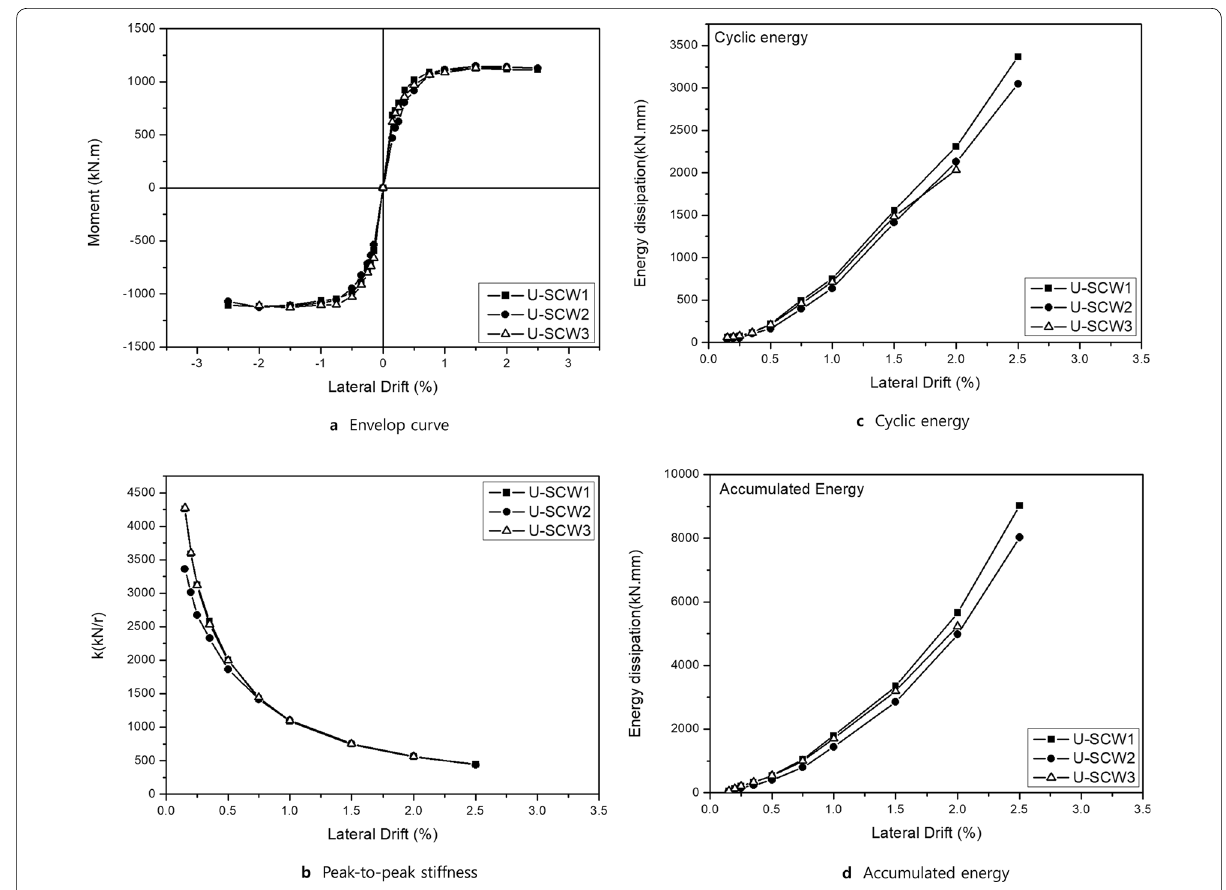
Fig. 15 Comparisons of structural performances for specimens ( P u